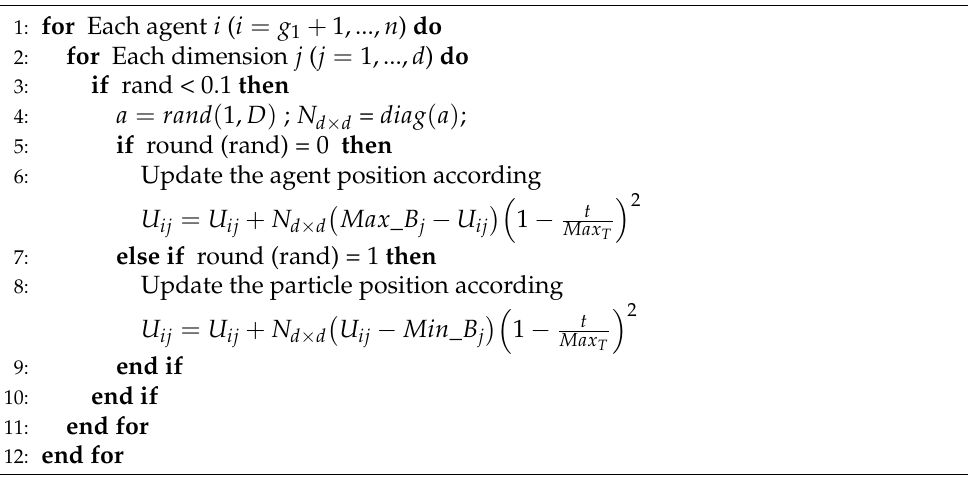
Algorithm 1 The non-uniform mutation operator.